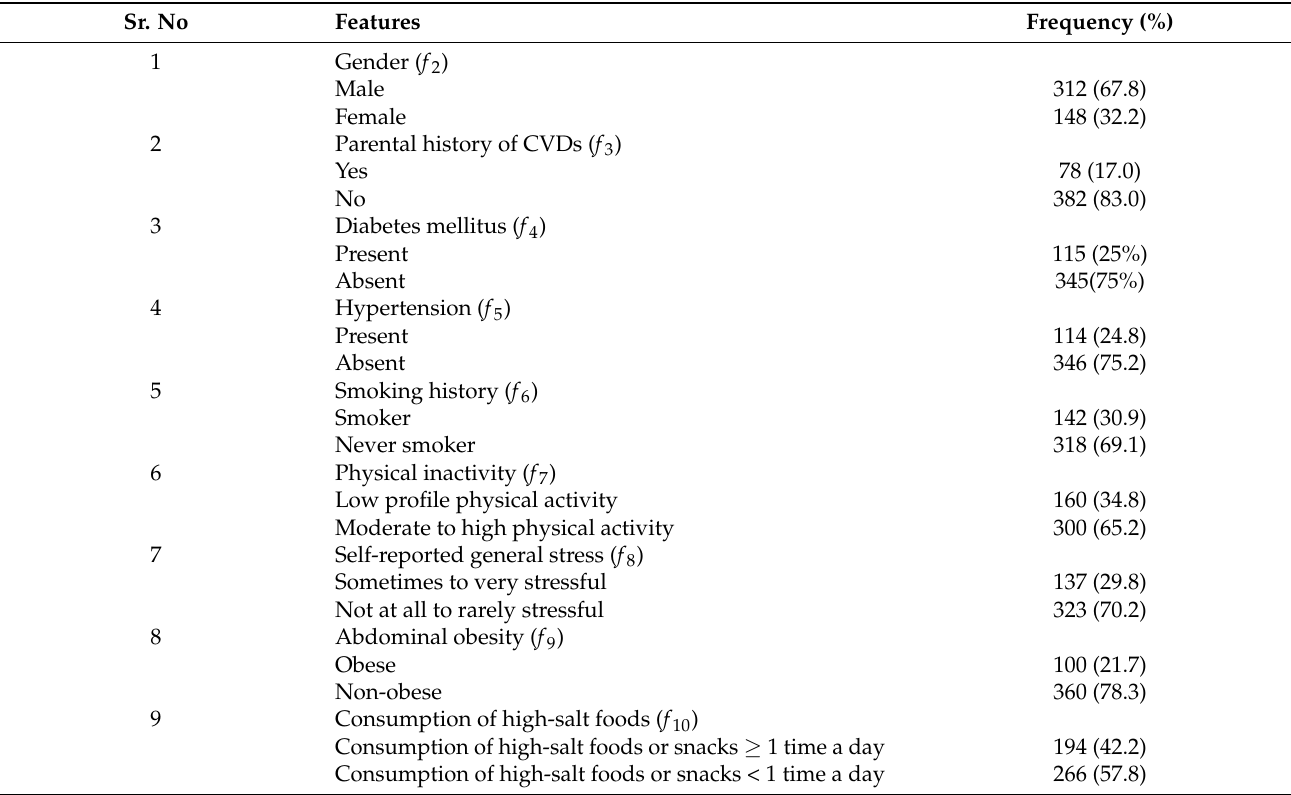
Table 1. General characteristics of binary features of the